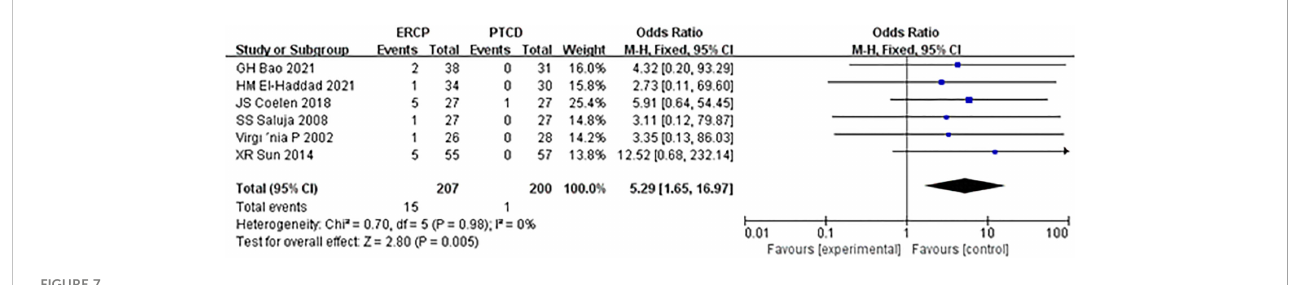
FIGURE 7 Forest plot comparing the incidence of procedure-related pancreatitis.